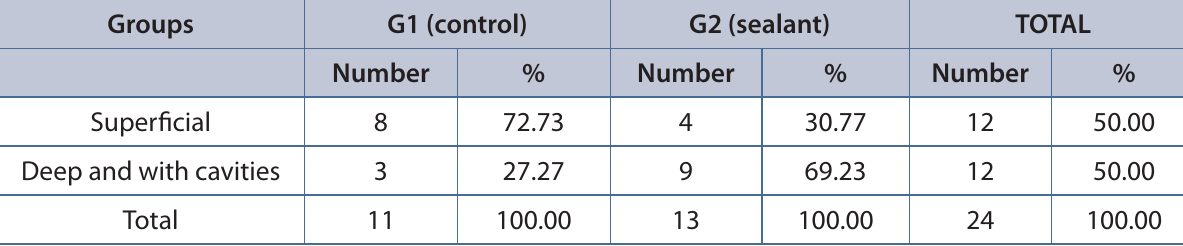
Table 1. Ulcer depth in the studied groups Groups G1 (control) G2 (sealant) TOTAL Number % % Superficial Deep and with cavities 3 27.27 Total